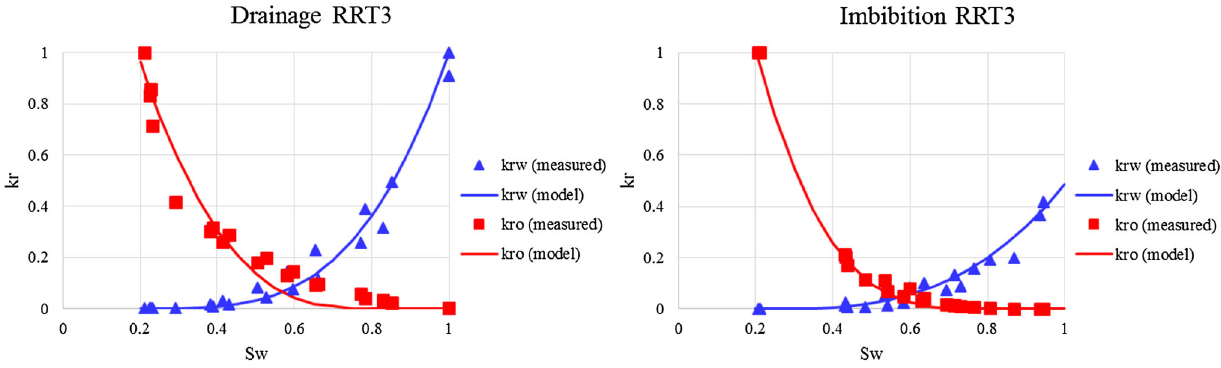
Fig. 22 Drainage and imbibition K r correlation for RRT 3